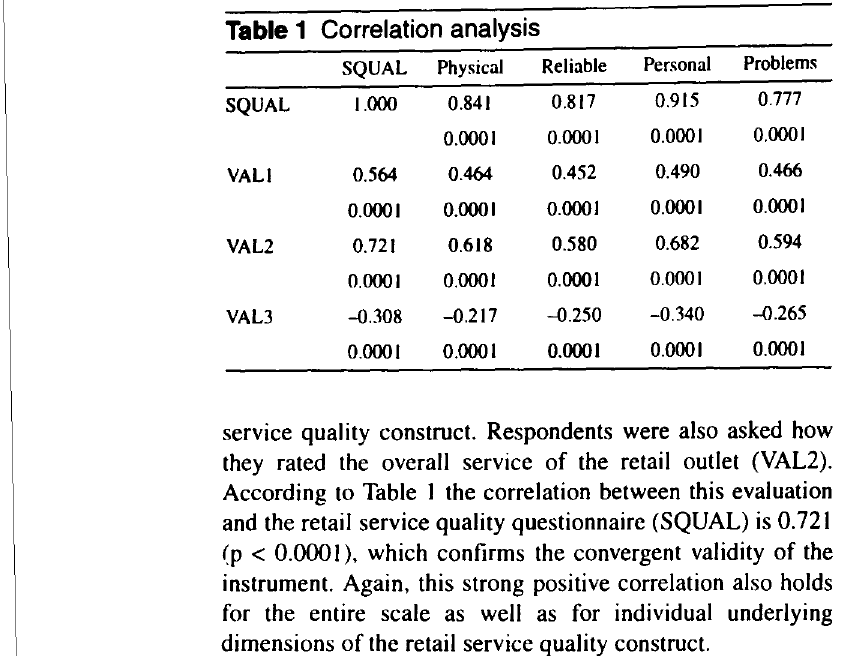
Table 1 Correlation analysis